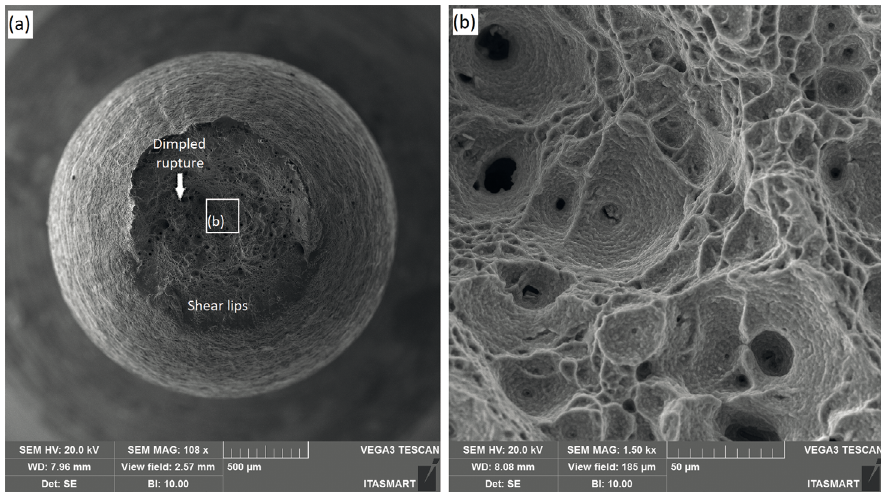
Figure 9: Secondary electron SEM images showing the fracture morphology of the MAR-SA crept at 650 ºC and 300 MPa. (a) The dimpled rupture surrounded by shear lips (characteristic of ductile fracture). (b) Equiaxed dimples at the location enclosed in Fig. 9a.